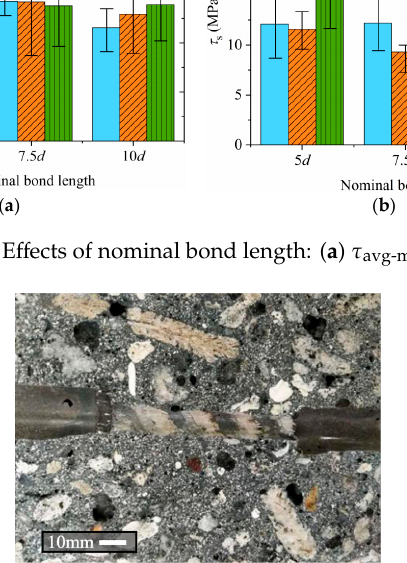
Figure 20. Detached ribs on the surface of fiber-reinforced polymer (FRP) bar.